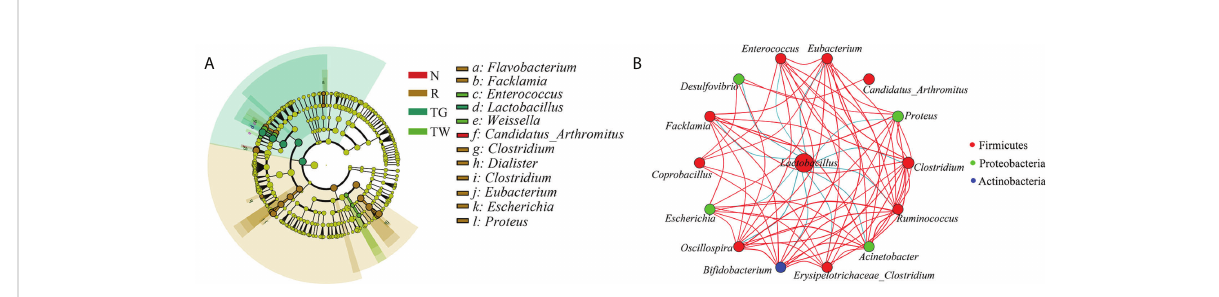
FIGURE 4 Core differential bacteria analysis of small intestine microbiota. (A) Cladogram of linear discriminant analysis effect size (LEfSe) analysis at the genus level (linear discriminant analysis [LDA] score > 4). N, normal control group; R, antibiotic-associated diarrhea (AAD) restore group; TW, Qiwei Baizhu Powder (QWBZP) decoction group; TG, total glycosides of Qiwei Baizhu Powder (QWBZP-TG) group. (B) Network of the correlation between major genera. The color of each spot corresponds to different phyla. Red and blue lines represent positive and negative correlation, respectively.